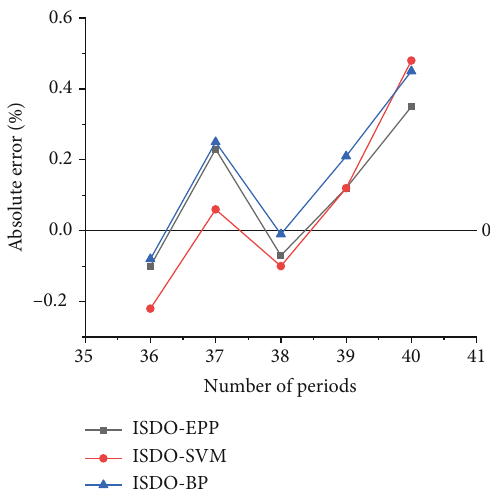
Figure 4: Absolute error of three models in example